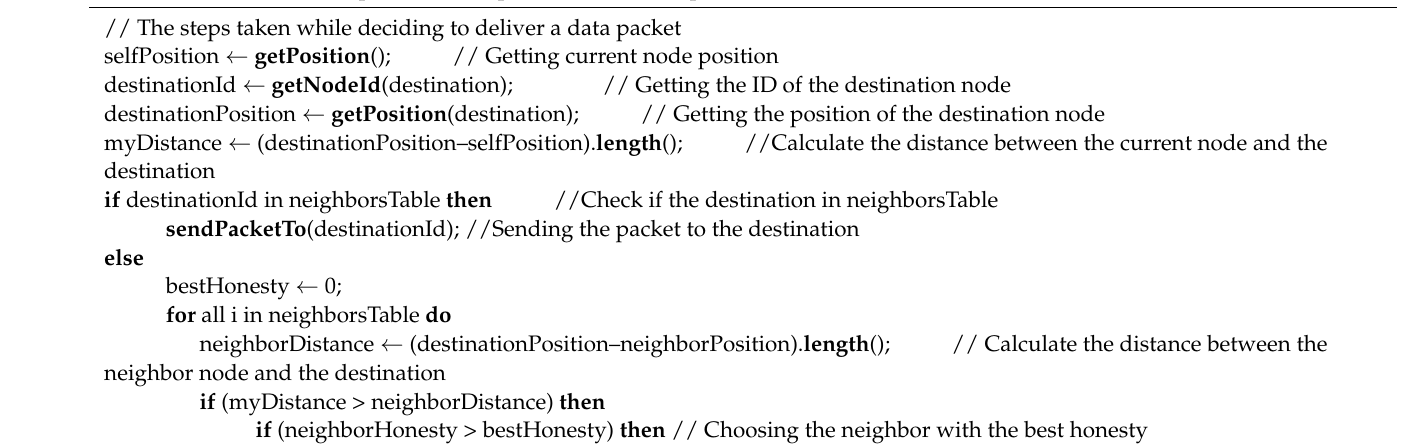
Algorithm 3. The next-hop selection steps in the SecE-V2X